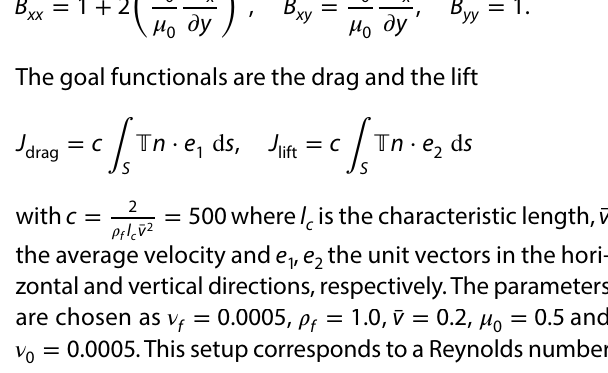
Fig. 3 Error of the drag (top) and the lift (bottom) for the Oldroyd-B benchmark